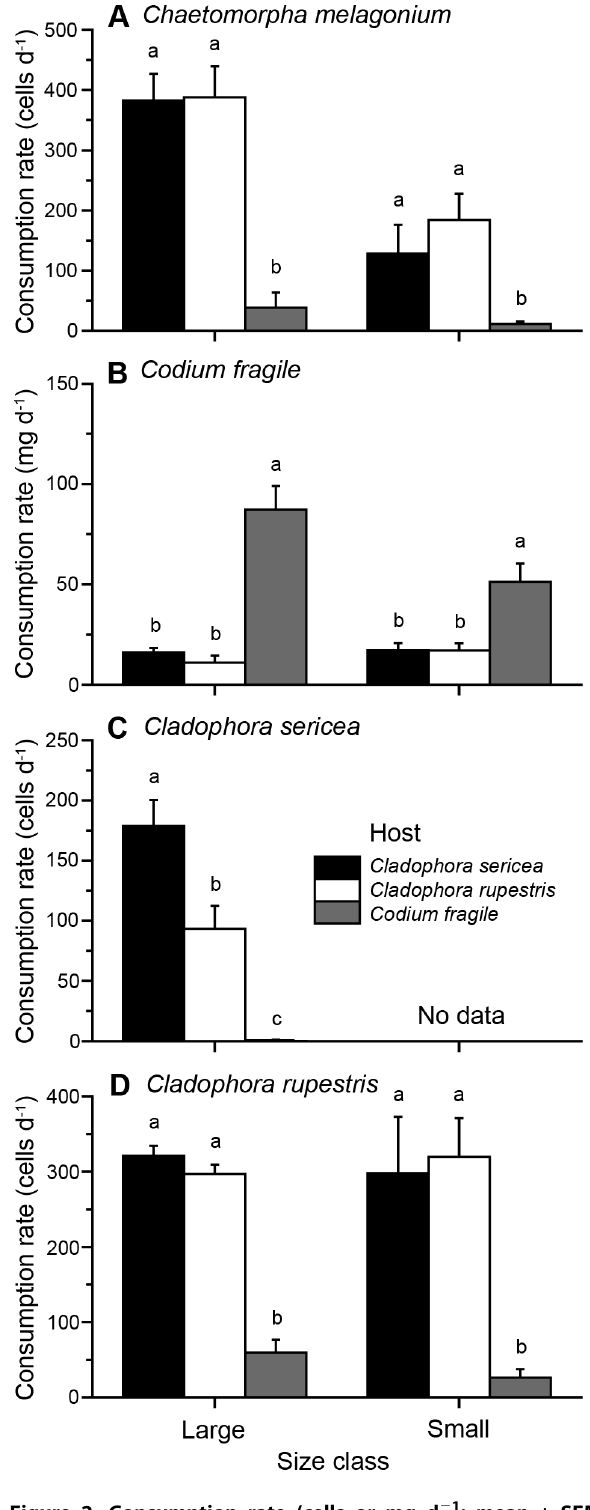
Figure 2. Consumption rate (cells or mg d 2 1 ; mean + SEM, n=10) of large and small Elysiaviridis individuals from different original algal hosts ( Cladophorasericea , Cladophorarupestris , and Codiumfragile ) on different algal diet species A) Chaetomorpha melagonium , B) C.fragile , C) C.sericea , and D) C.rupestris . Different letters above bars within each E. viridis size class indicate significant differences at a =0.05 (R-E-G-W F procedure).